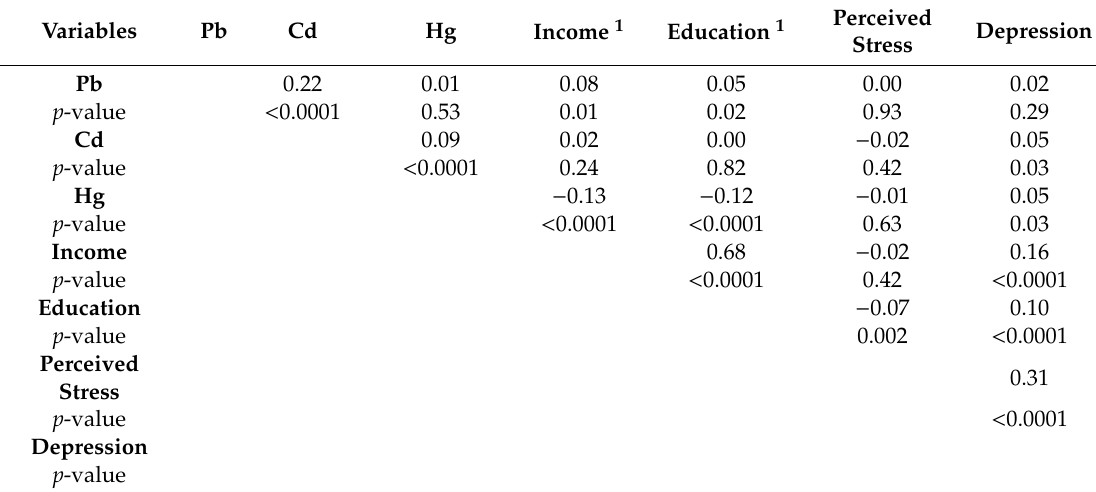
Table 3. Spearman correlation coe ffi cients for tertiles of heavy metals, psychosocial stress, and categories of sociodemographics.